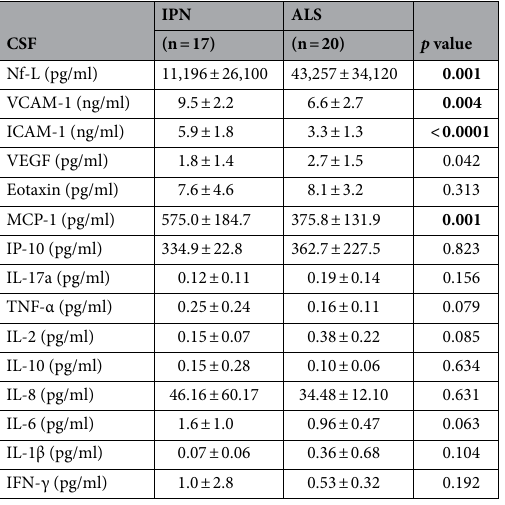
Table 2. Biomarkers levels in CSF of patients with IPN or ALS. Mann Whitney test p values below 0.01 are indicated in